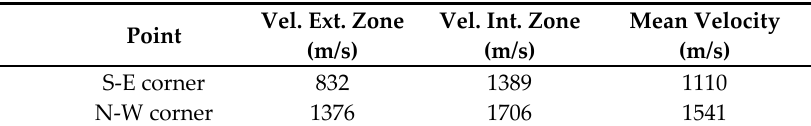
Table 3. Direct STs, Krishna Temple.